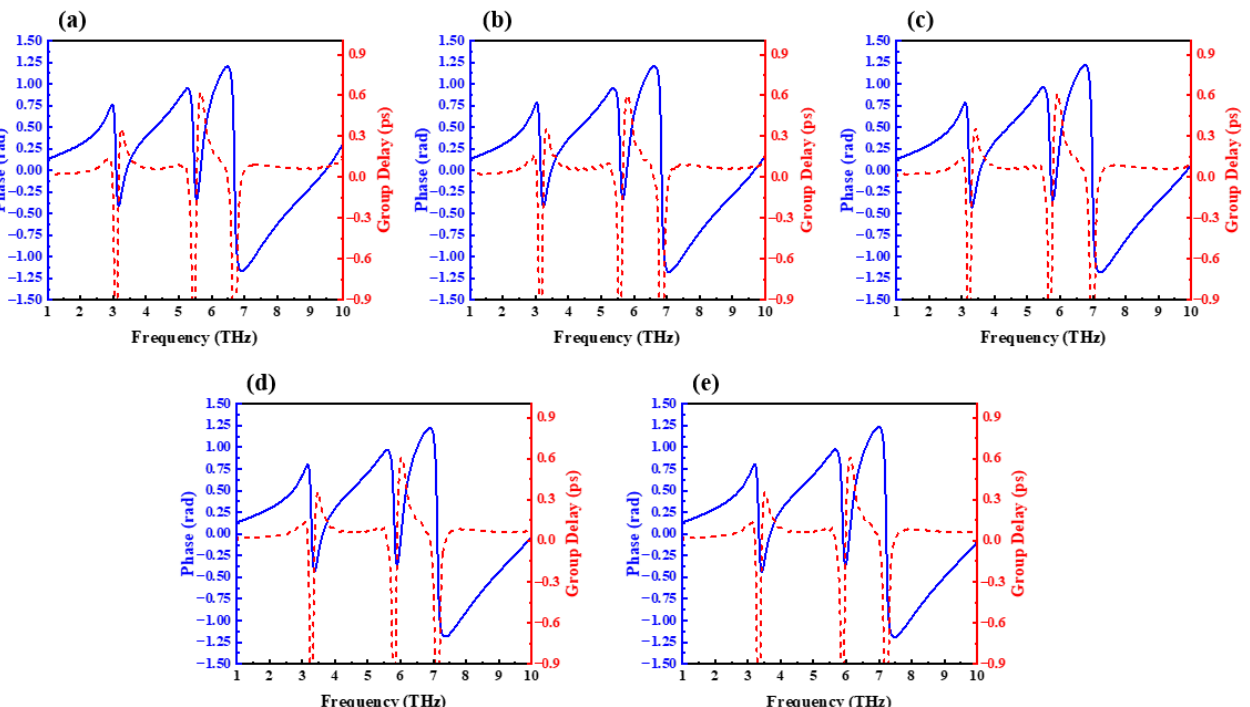
Figure 6. Phase curve and group delay curve with different chemical potential. ( a ) 0.6eV, ( b ) 0.625eV, ( c ) 0.65eV, ( d ) 0.675eV, and ( e ) 0.7ev.